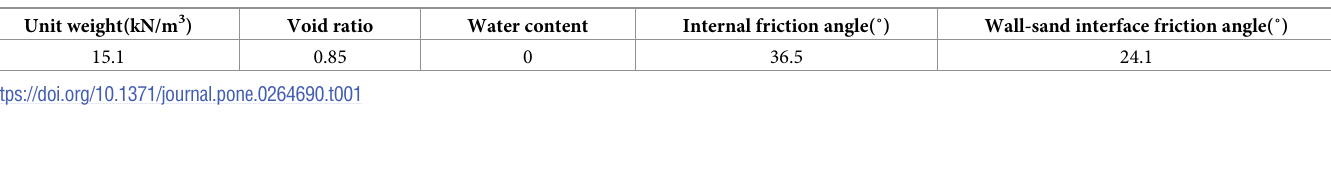
line fracture zone.